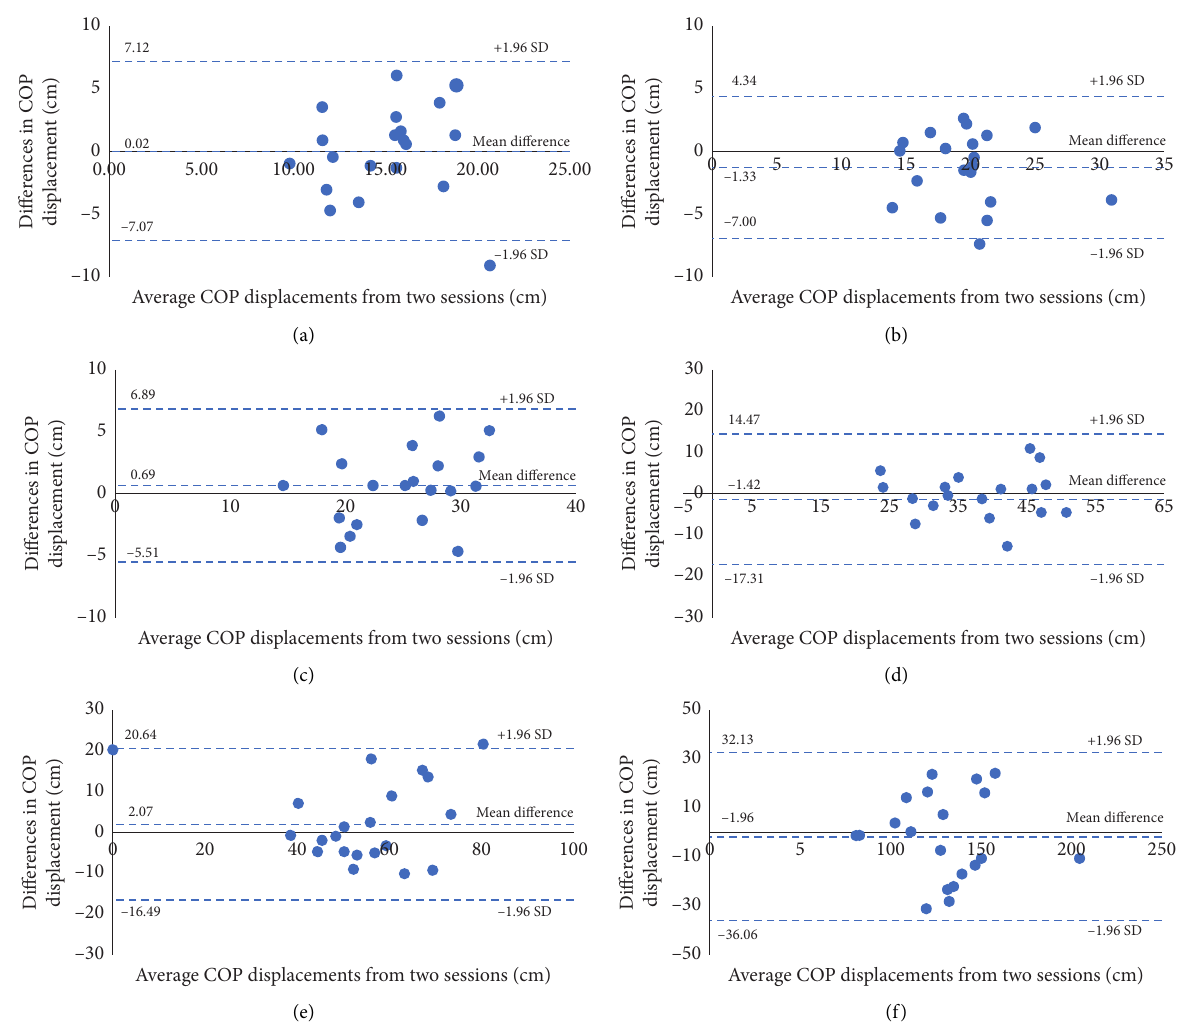
Figure 7: Bland–Altman plots and limits of agreements (LOAs) of COP displacements in sessions 1 and 2 in six testing conditions. (a) COP displacements during DLS-SW-EO. (b) COP displacements during DLS-SW-EC. (c) COP displacements during DLS-FT-EO. (d) COP displacements during DLS-FT-EC. (e) COP displacements during SLS-EO. (f) COP displacements during